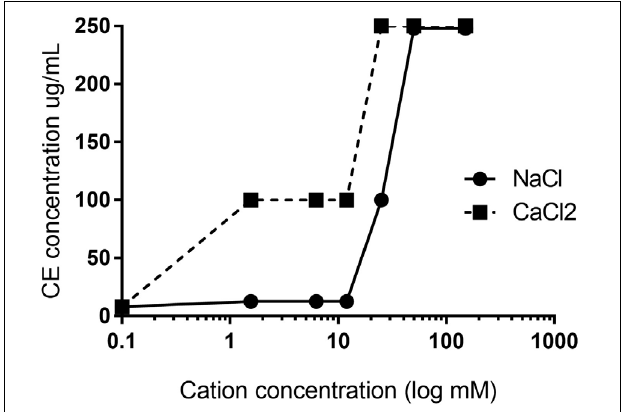
FIGURE 6 | Electrostatic interactions and the impact of cations on the antimicrobial activity of NuriPep 1653. CE concentrations against colSAB were determined for NuriPep 1653 in the presence of increasing concentrations of NaCl or CaCl 2 . The initial CE under standard conditions was 12 µ g/mL.